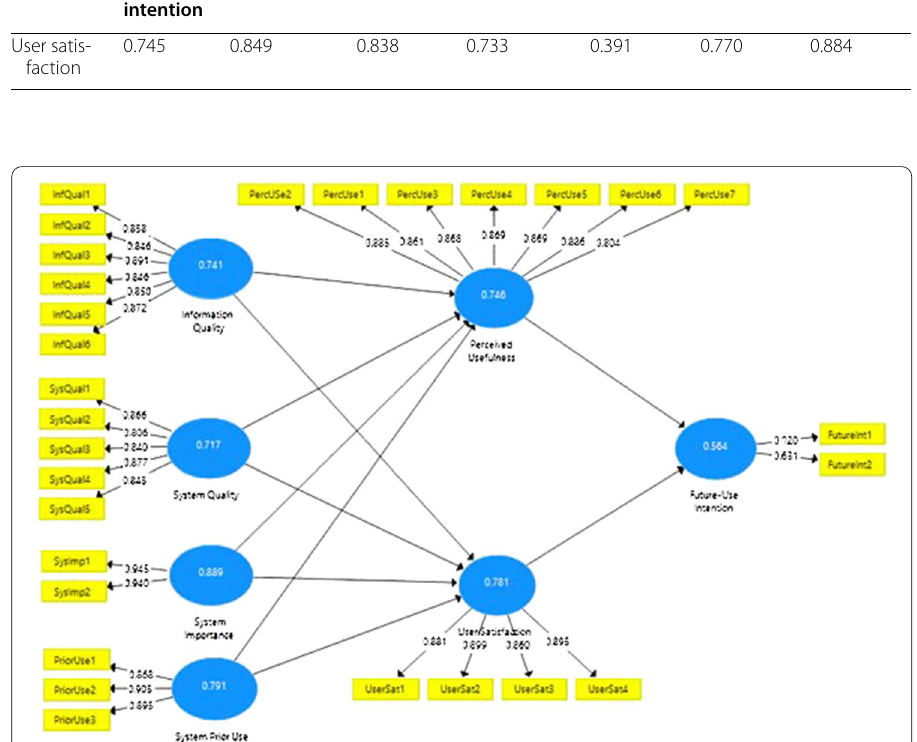
Fig. 3 Measurement indicators outer-loadings and